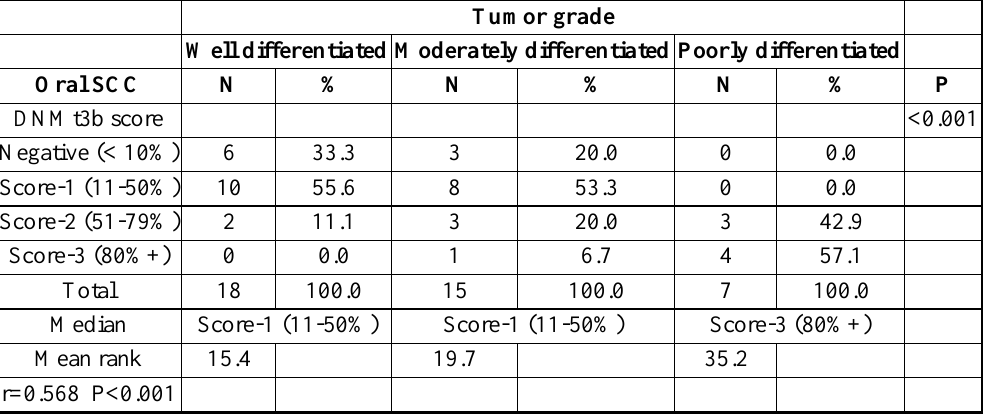
Table 4: The difference in median score category of DNMT3B among the three tumor grades among cases with oral SCC. Tumor grade